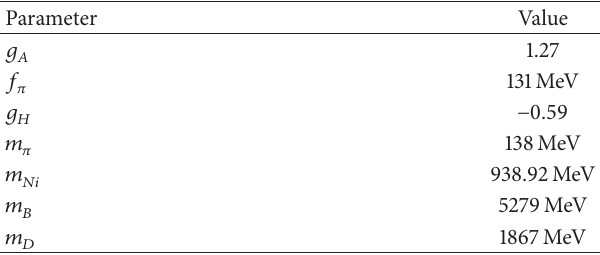
Table 1: Potential parameters used for the bound state of heavy pentaquarks [15].